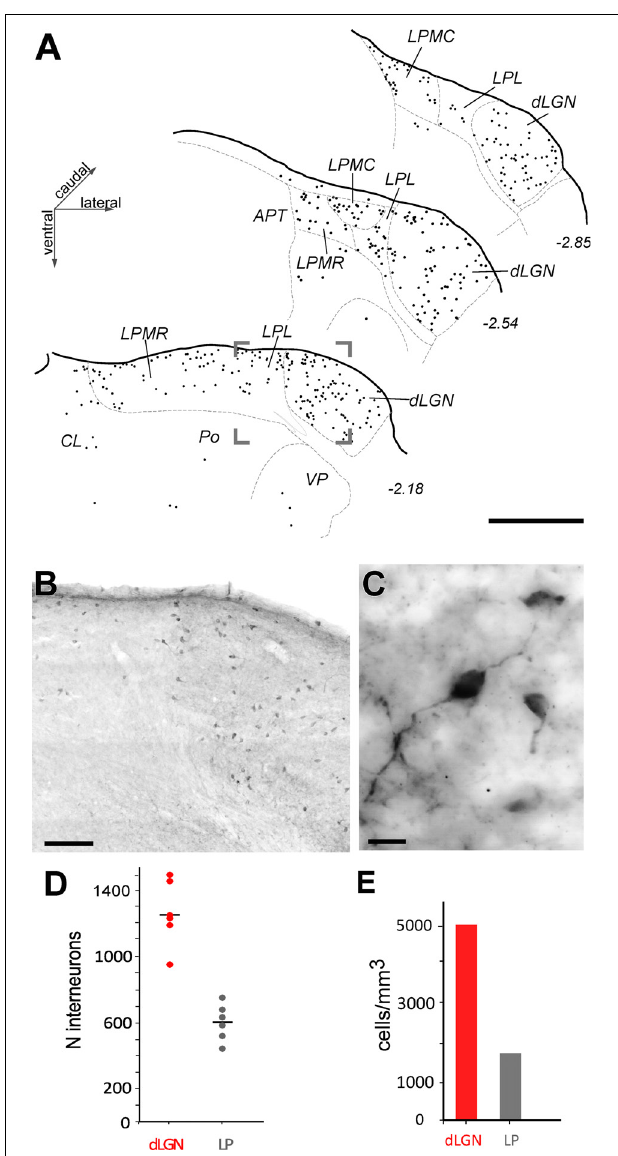
FIGURE 5 | Distribution and number of GABAergic interneurons in the visual thalamic nuclei. (A) Camera-lucida drawings of three coronal sections of the visual thalamus. GABA-immunolabeled cells are indicated by black dots; each dot represents a cell. (B) Low-magnification image taken from the area indicated by a frame in (A) . (C) High magnification image showing three immunostained cells displaying typical interneuronal size and morphology. Scale bars: (A) = 500 µ m; (B) = 50 µ m; (C) = 10 µ m. (D,E) GABAergic neuron number (D) and density (E)